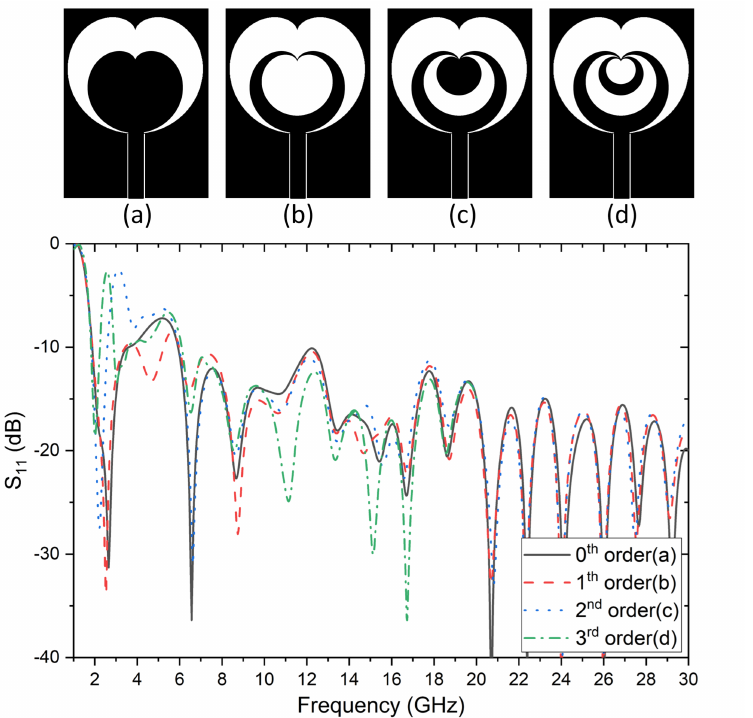
Figure 2. Simulated reflection coefficients for the fractal antenna geometries with different iteration orders. ( a ) 0th iteration order; ( b ) 1th iteration order; ( c ) 2nd iteration order; ( d ) 3rd iteration